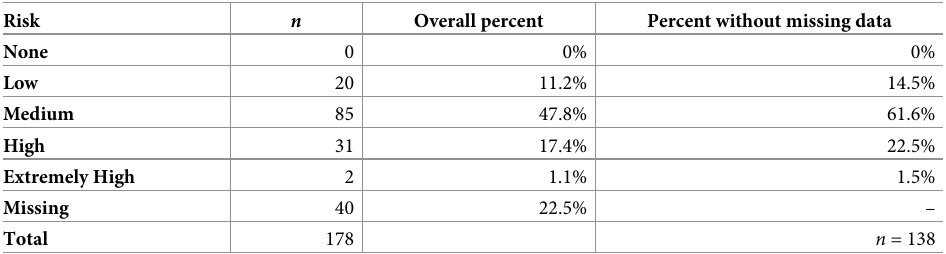
Table 2. Perception of overall